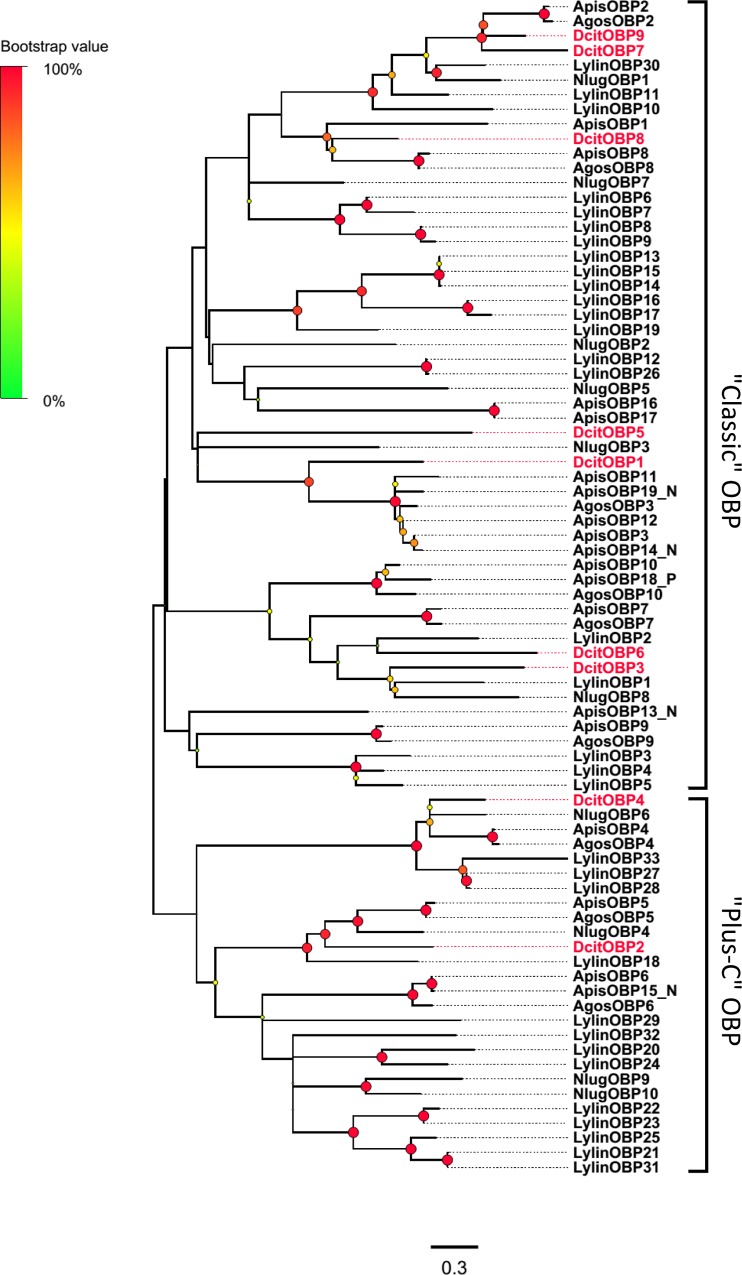
Phylogenetic relationship between DictOBPs.